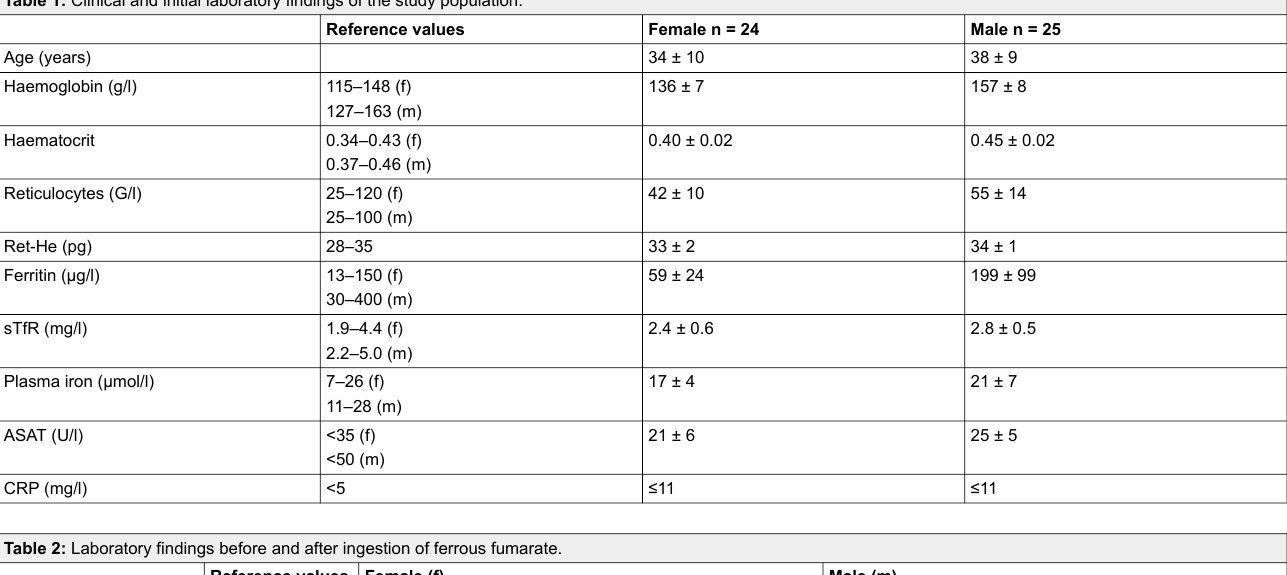
Table 1: Clinical and initial laboratory findings of the study population.